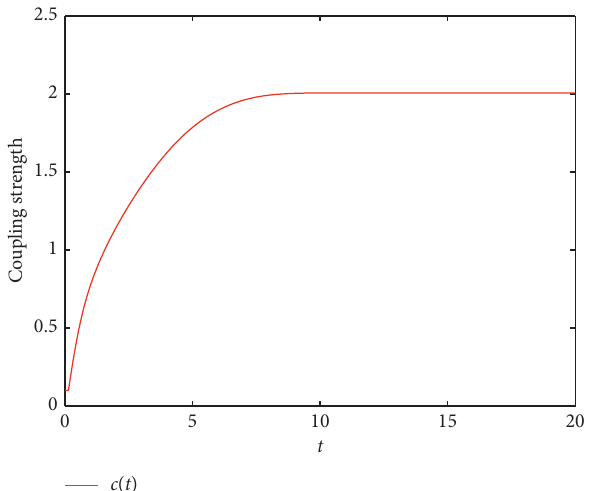
Figure 6: The orbit of adaptive coupling strength c ( t ).